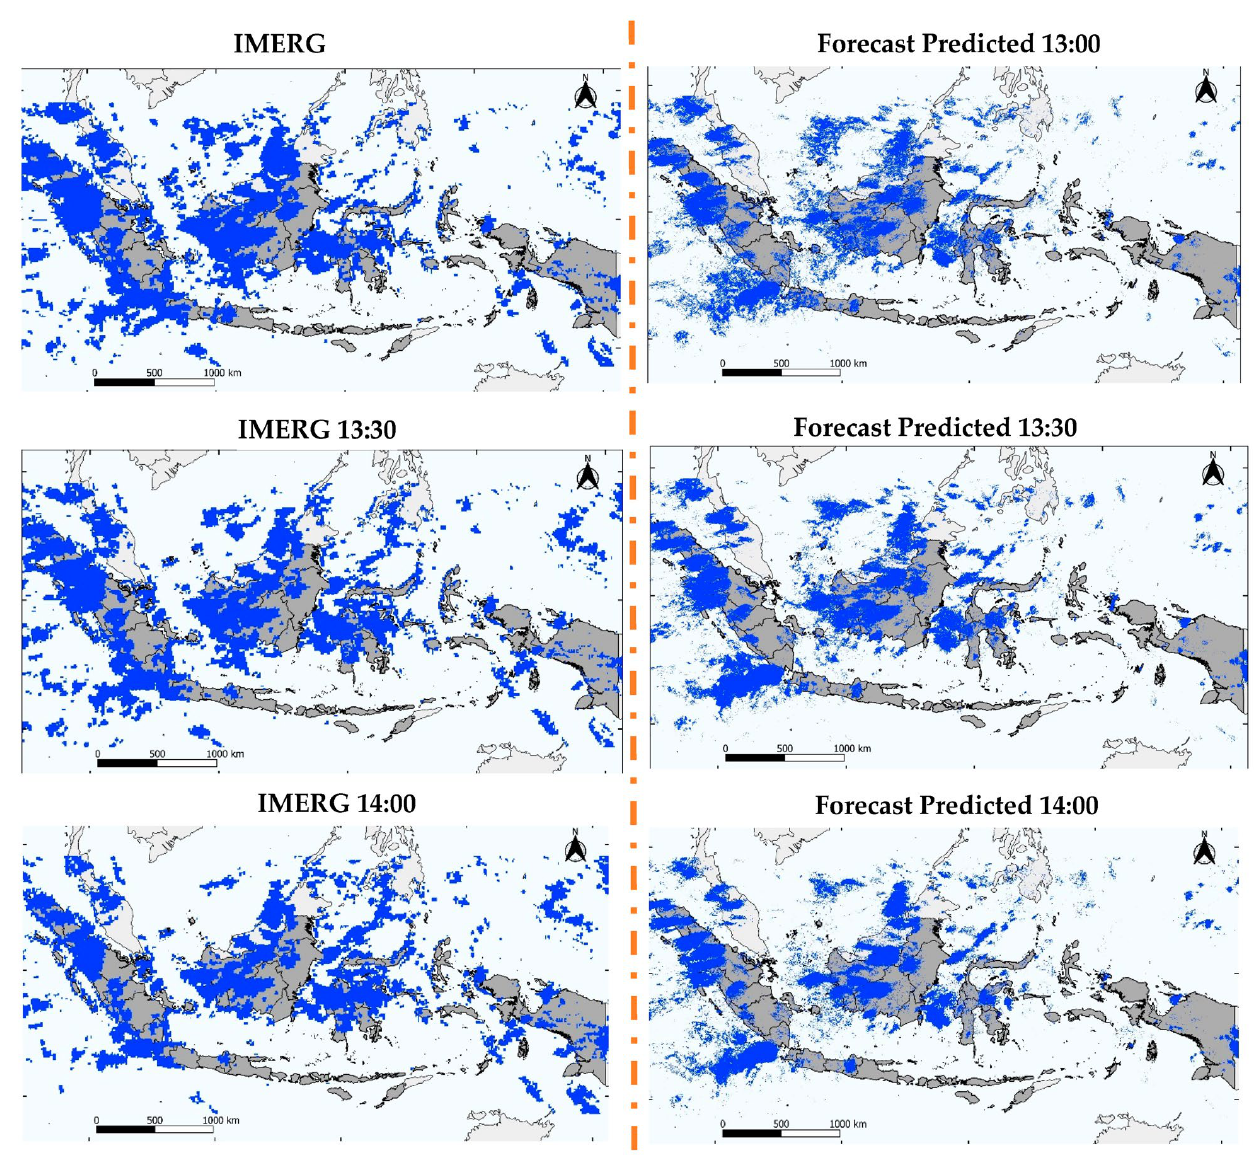
Figure 5. The visual comparison between IMERG data as the ground truth and forecast predicted rain and non-rain pixel, blue color (other colors) represents of the rain pixels (non-rain pixels).